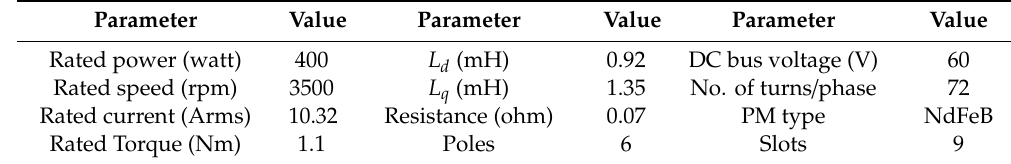
Table 1. Parameters of the benchmark PMSM.